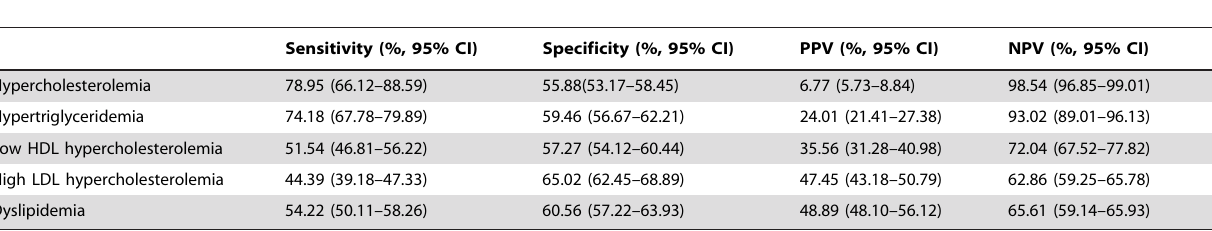
Table 3. Predictive performance of resting pulse rate to screen lipid metabolic dysfunctions in rural adult subjects (n= 16,926).